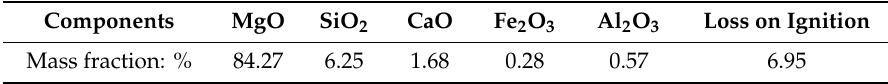
Table 1. The chemical compositions of the magnesia powder.